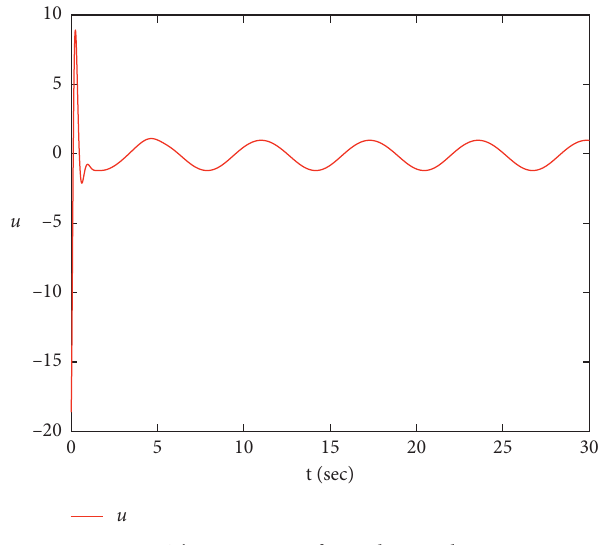
Figure 7: The trajectory of actual control input u